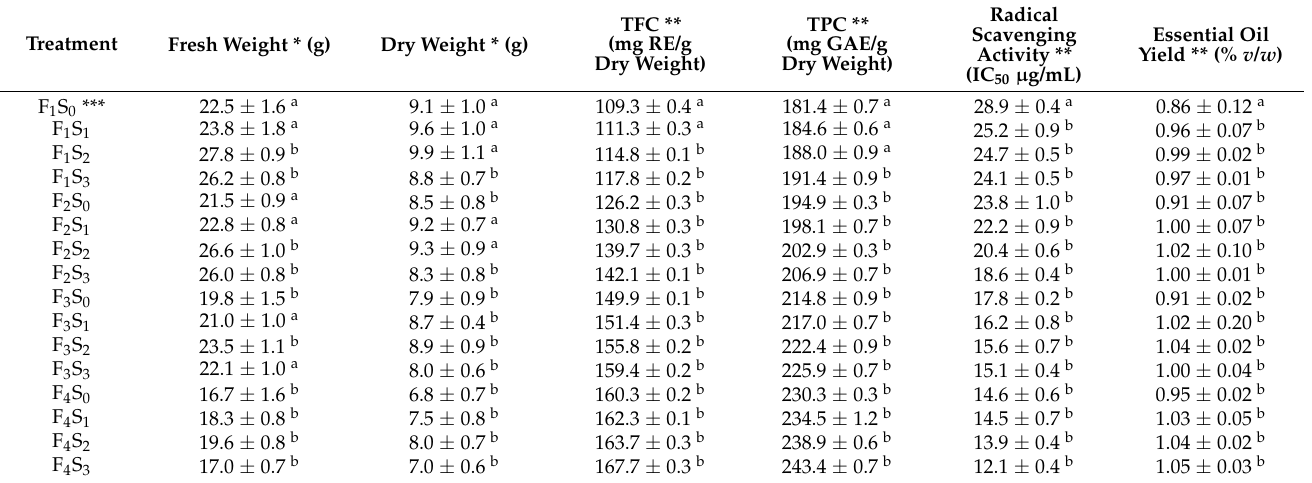
Table 1. Effects of drought stress and SA spraying on fresh weight, dry weight, TFC, TPC, and radical scavenging